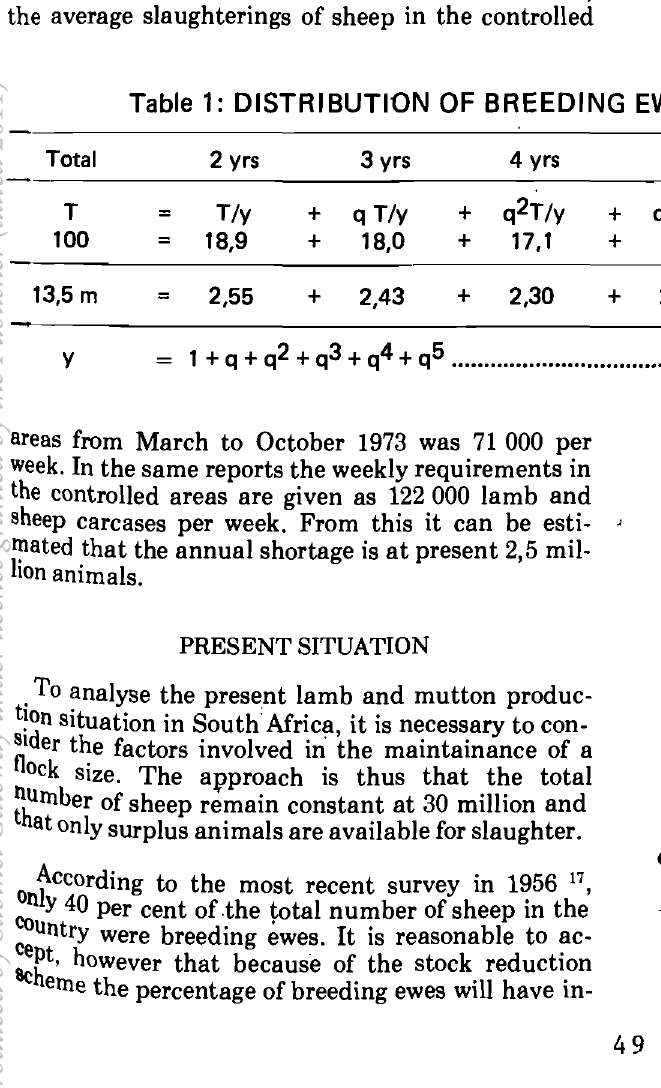
Table 1: DISTRIBUTION OF BREEDING EWES IN DIFFERENT AGE GROUPS